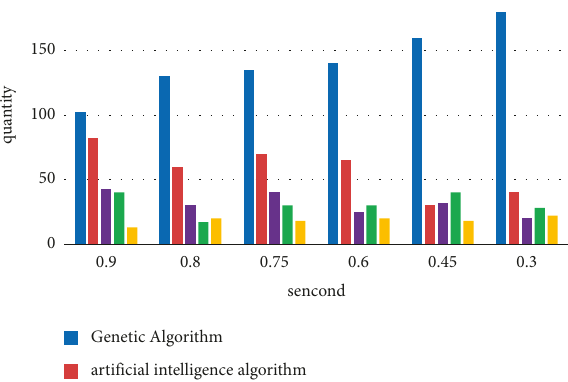
Figure 6: Amount of attention of users at the same time.